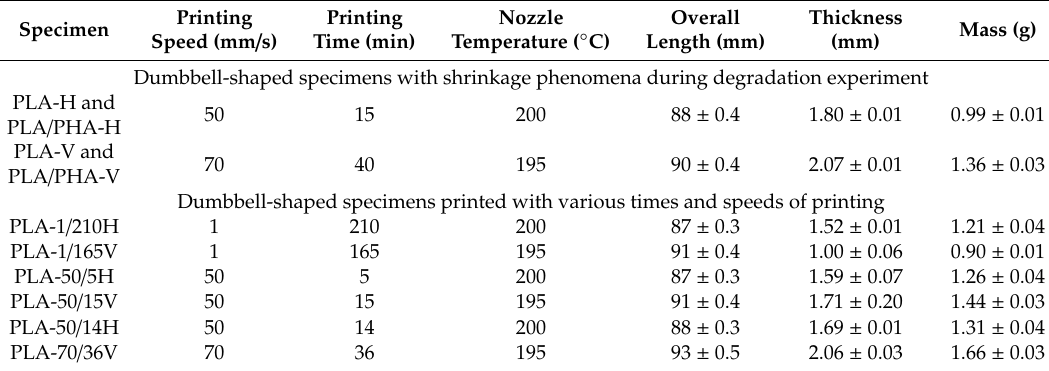
Table 4. Printer settings for preparation PLA and PLA / PHA dumbbell-shaped specimens obtained by 3D printing in horizontal (H) and vertical (V) directions and average specimen’s